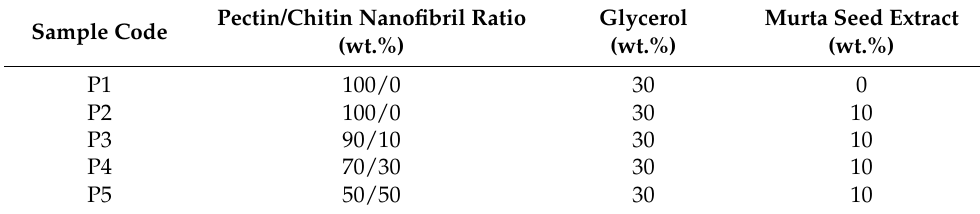
Table 4. Codes and film